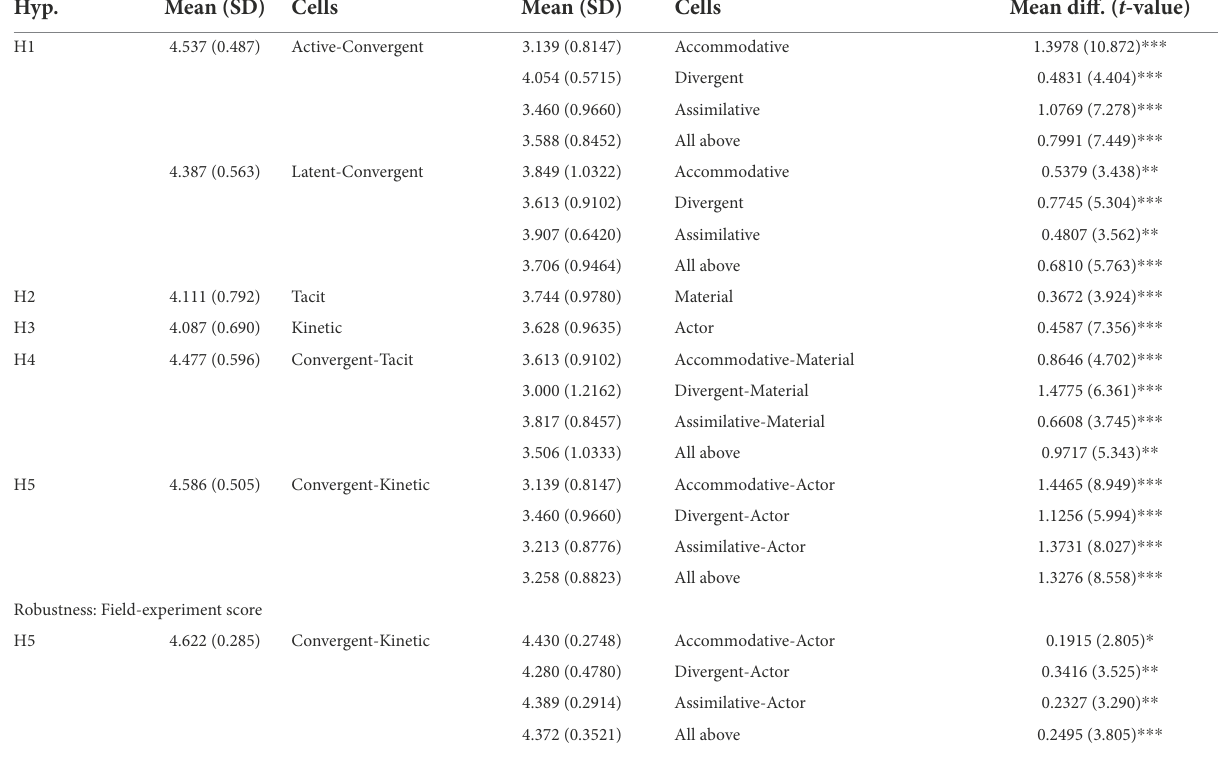
TABLE 5 Hypothesis results.